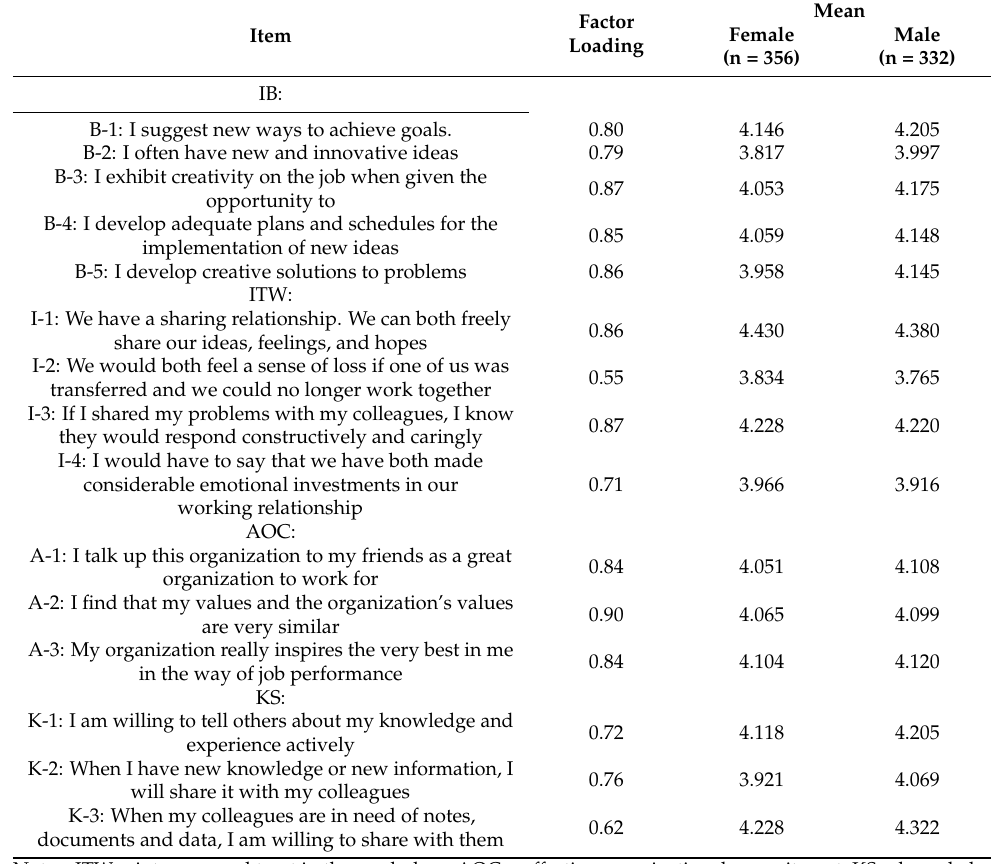
Table 2. Factor loadings of the confirmatory factor analysis model and means between genders.